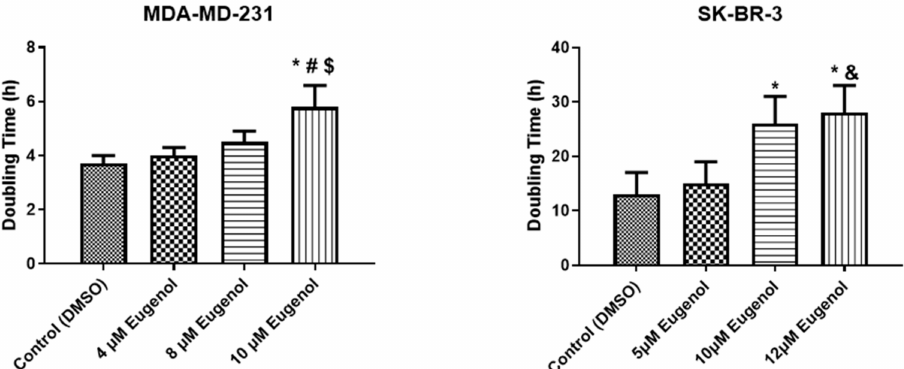
Figure 2. Population doubling times (PDTs) of MDA-MB-231 and SK-BR-3 cells treated with different concentrations of eugenol. The cells were seeded (2 × 10 5 cells/well) in an E-16 plate and continu- ously observed for 72 h, during which time the cell index values were measured. Cell proliferation was observed at 15-min intervals. Each data point signifies an average value ± SD. All cells were analyzed in triplicate. *, #, $, and & indicate significant changes when compared to the control condition when 4 µ M, 8 µ M, and 5 µ M of eugenol were applied, respectively ( p <